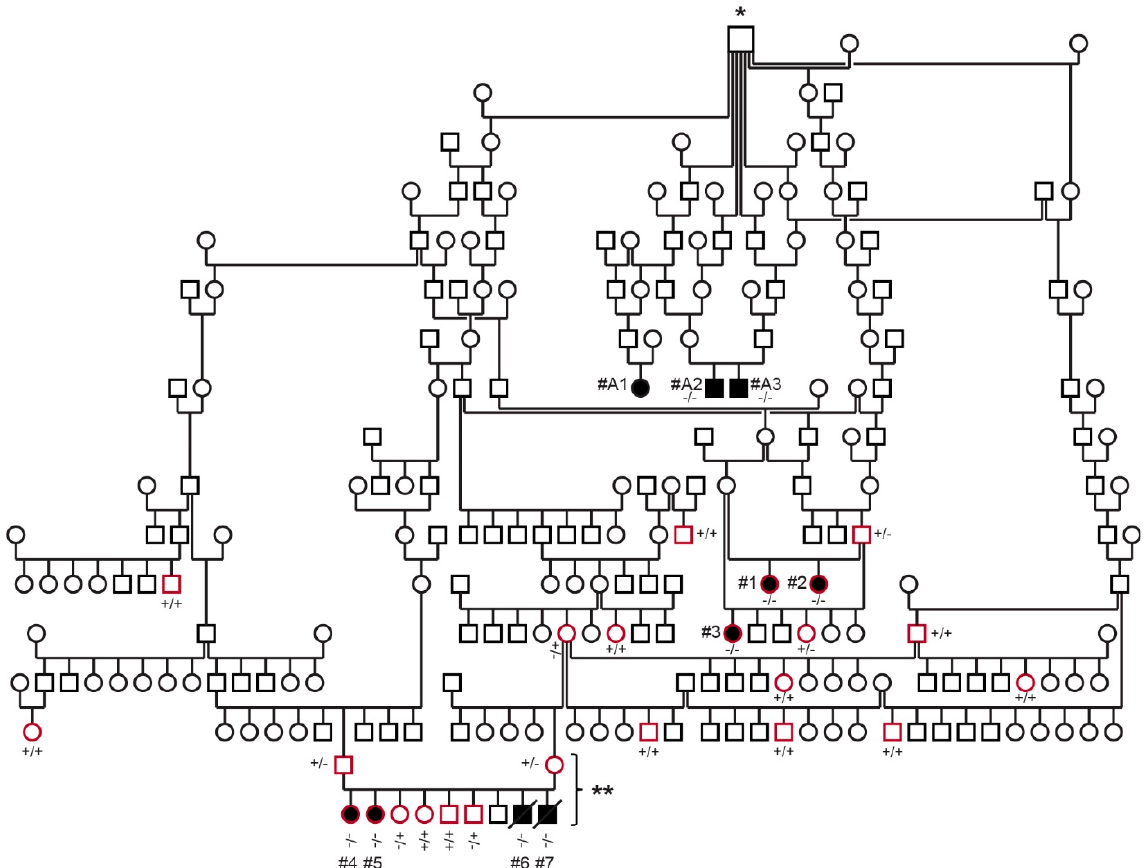
Figure 1. Pedigree and genotyping of the ESSP family with DAMS. Squares are males, and circles are females; affected dogs are indicated with black-filled symbols, and open symbols represent unaffected dogs (or dogs without phenotype information); a diagonal line represents perinatal death. The dogs circled in red were clinically examined and genotyped during this study. Dogs #A1–A3 represent the DAMS-affected dogs from Australia, which were previously reported in [17]. Genotypes for the EHBP1L1 :c.3120delC with mutant (-) and wild type (+) allele are indicated for dogs from which DNA samples were available. The symbol marked by * represents the first known common ancestor of all investigated affected dogs. The litter marked with ** comprising both parents and six available offspring (excluding dead puppies) was used for parametric linkage analysis.